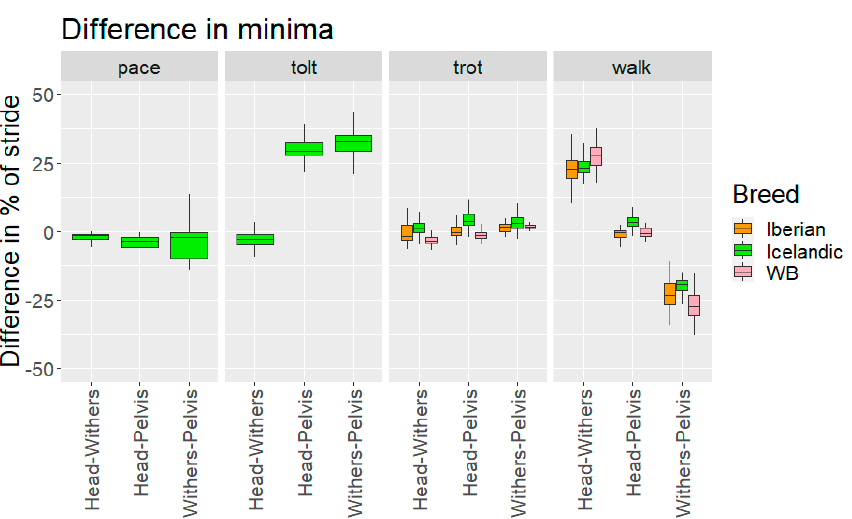
Figure 7. Timing difference in vertical displacement minima between head, withers and pelvis for the different breeds and gaits studied, based on LH hoof-on stride split. WB: Warmblood horses. A positive Head–Withers value indicates that the head reaches the minima first. A positive Head–Pelvis means the head reaches the minima first. A positive Withers–Pelvis means the withers reaches the minima first.